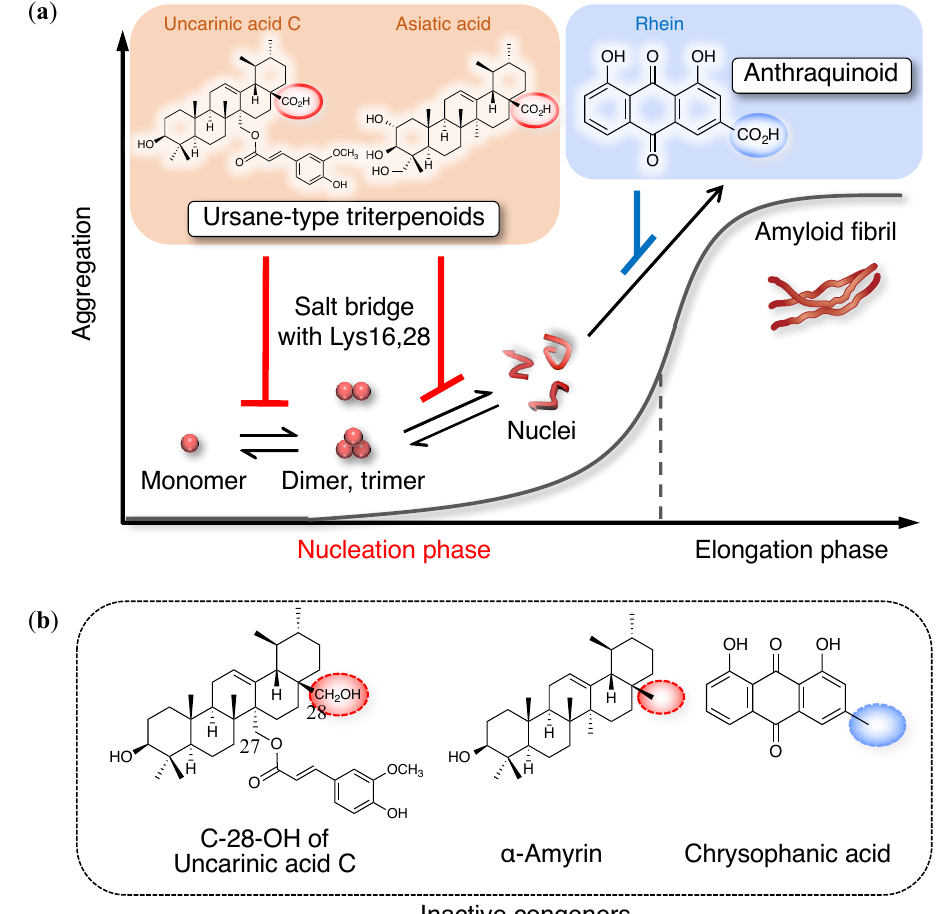
Figure 4. ( a ) Overview of aggregation inhibitors with ion bridge formation of their carboxy group with basic amino acids in A β 42 (only on-pathway route is indicated). ( b ) Their inactive congeners as an ursane-type triterpenoid or an